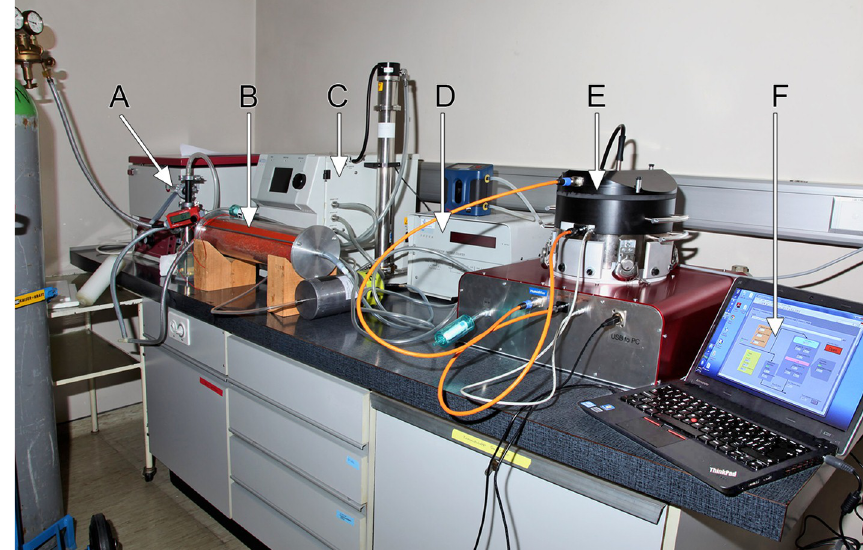
Figure 3. Experimental setup for deposition efficiency measurements with fluorescent polystyrene latex particles (PSL) [38].